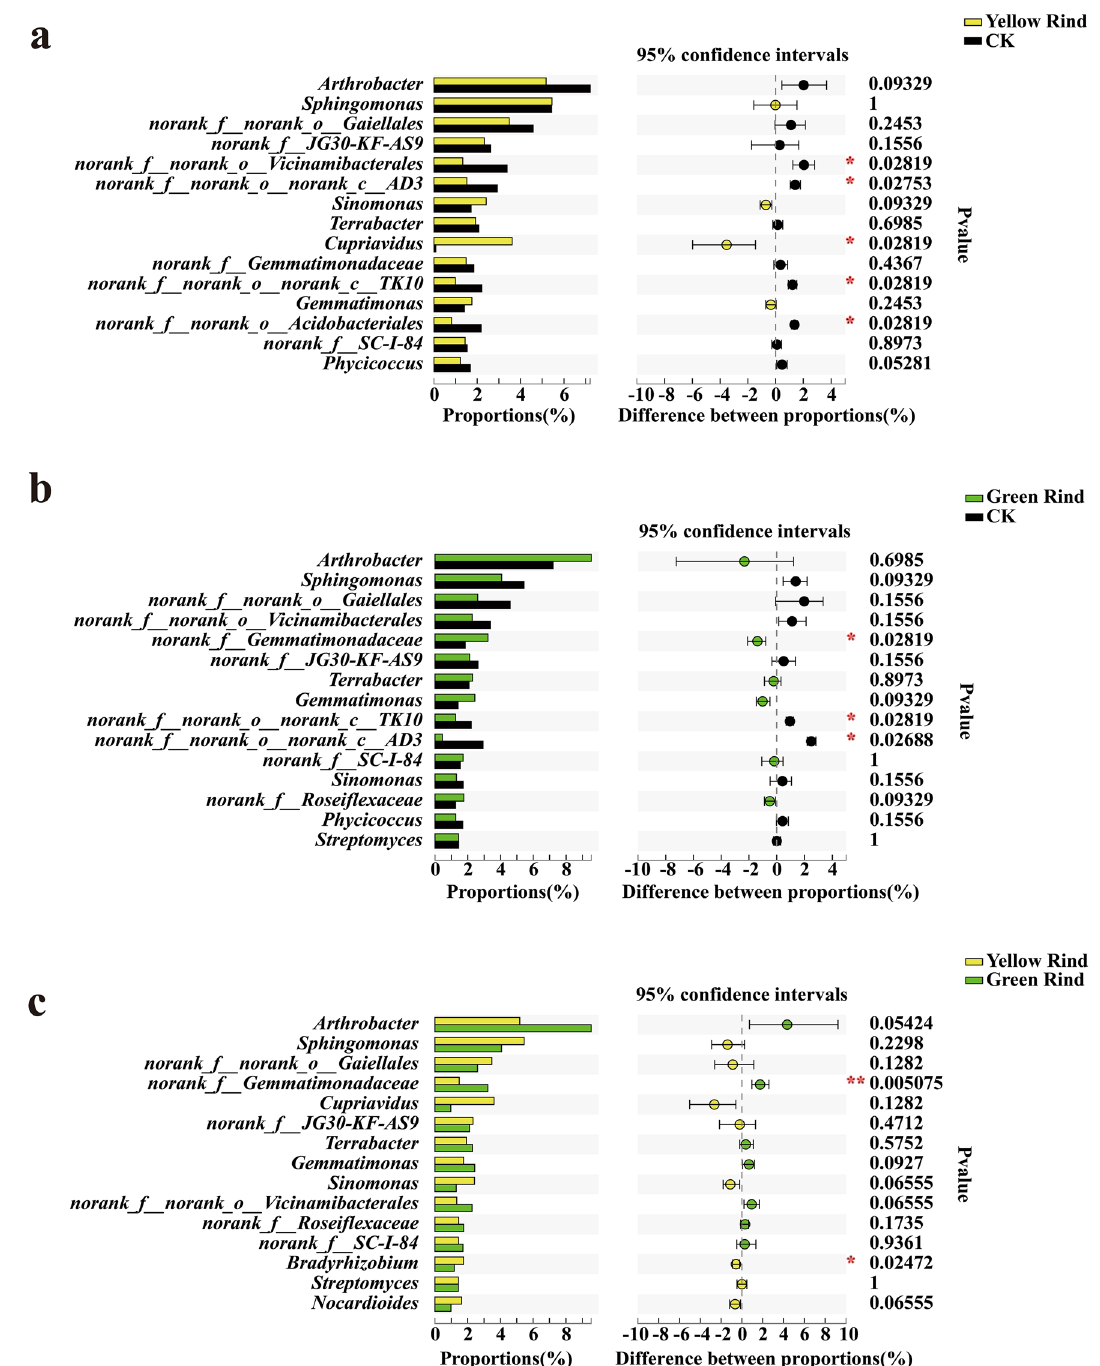
Figure 7. Difference test of soil bacteria at genus level among yellow, green rind watermelons and CK. *0.01 < p ≦ 0.05, **0.001 < p ≦ 0.01, *** p ≦ 0.001. (Some intermediate ranks in the taxonomic spectrum appeared in the comparison database without scientific names and were assigned as “norank”. That was, this rank was not